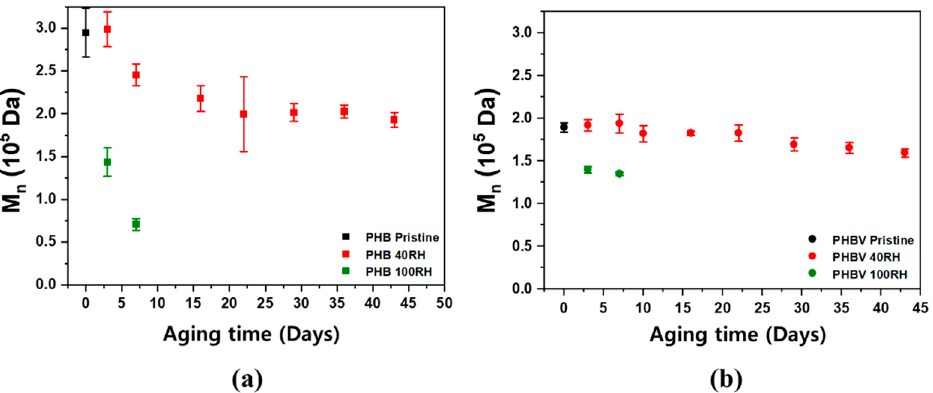
Figure 7. SEC determined M n values for ( a ) PHB and ( b ) PHBV samples aged in soil fully saturated with water (100% RH) and at 40% RH. Table 3. Summary of the changes on M n , T m , and degree of crystallinity with aging time of PHB and PHBV.